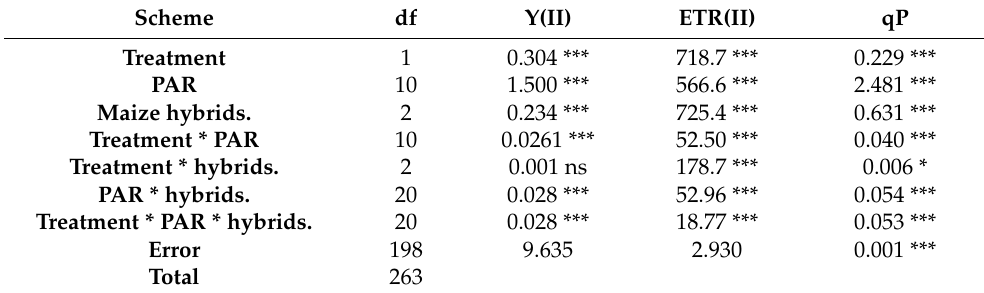
Table 1. Mean square values from analysis of variance (ANOVA) for Y(II), ETR(II), and qP of three maize ( Zea mays L.) hybrids differing in drought tolerance when two-week-old plants were subjected to three cycles of drought stress.